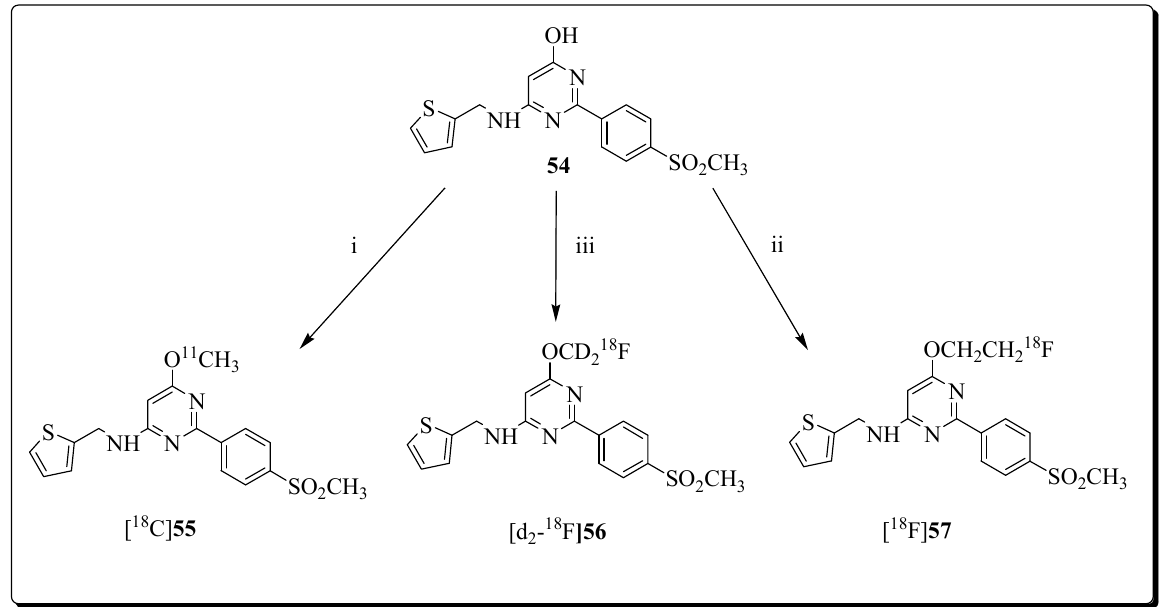
Figure 16. Radiosyntheses of [ 11 C] 55 , [ 18 F] 56 , and [ 18 F] 57 . Reagents and conditions: (i) [ 11 C]CH 3 I, DMF, TBAH, RT, 5 min; (ii) [ 18 F]FCH 2 CH 2 Br, DMF, Cs 2 CO 3 , 18-crown-6, 110 °C, 15 min; (iii) [ 18 F]FCD 2 Br, Cs 2 CO 3 , 18-crown-6, 110 °C, 15